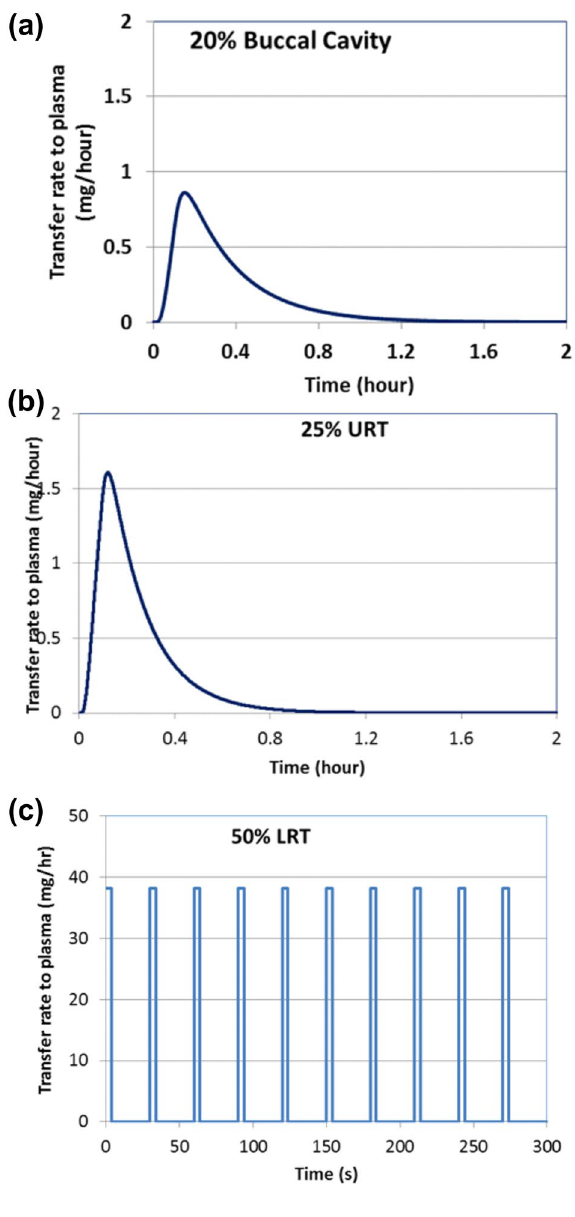
Figure 7. Rate of nicotine transfer to plasma from using an ENDS product with regional distribution shown in Fig. 2, calculated from permeation model. ( a ) 20% BC, ( b ) 25% URT, and ( c ) 50% LRT (5%